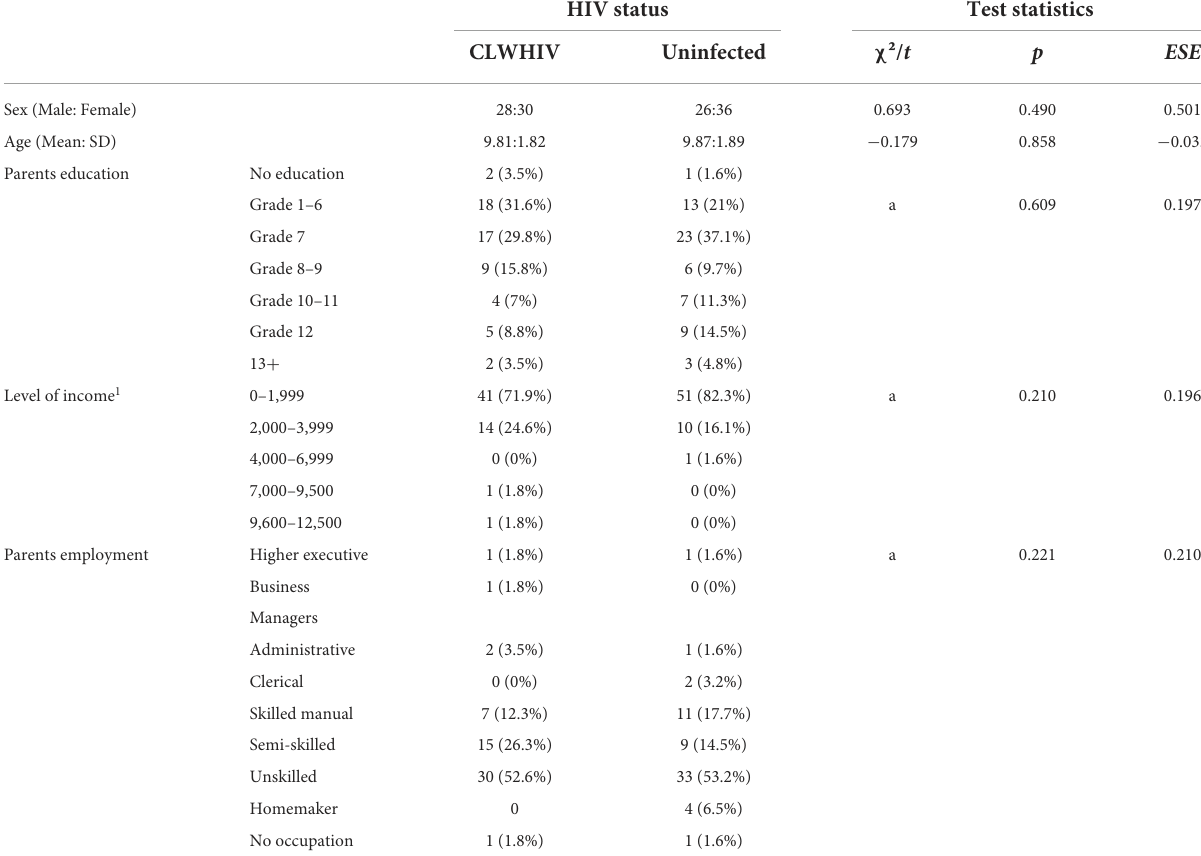
TABLE 1 Participant